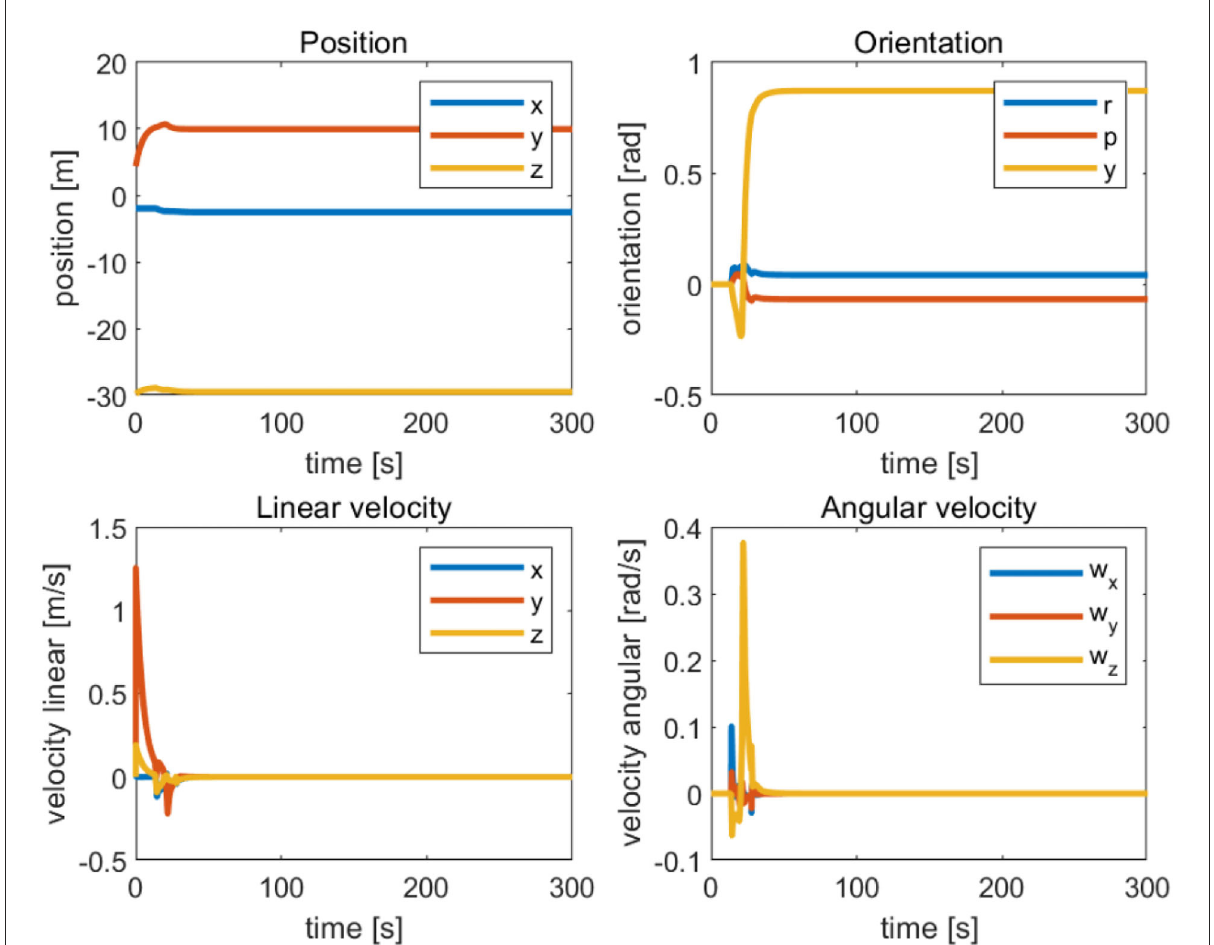
FIGURE5 Position-directional linear velocity angular velocity tracking curve of the completed vehicle